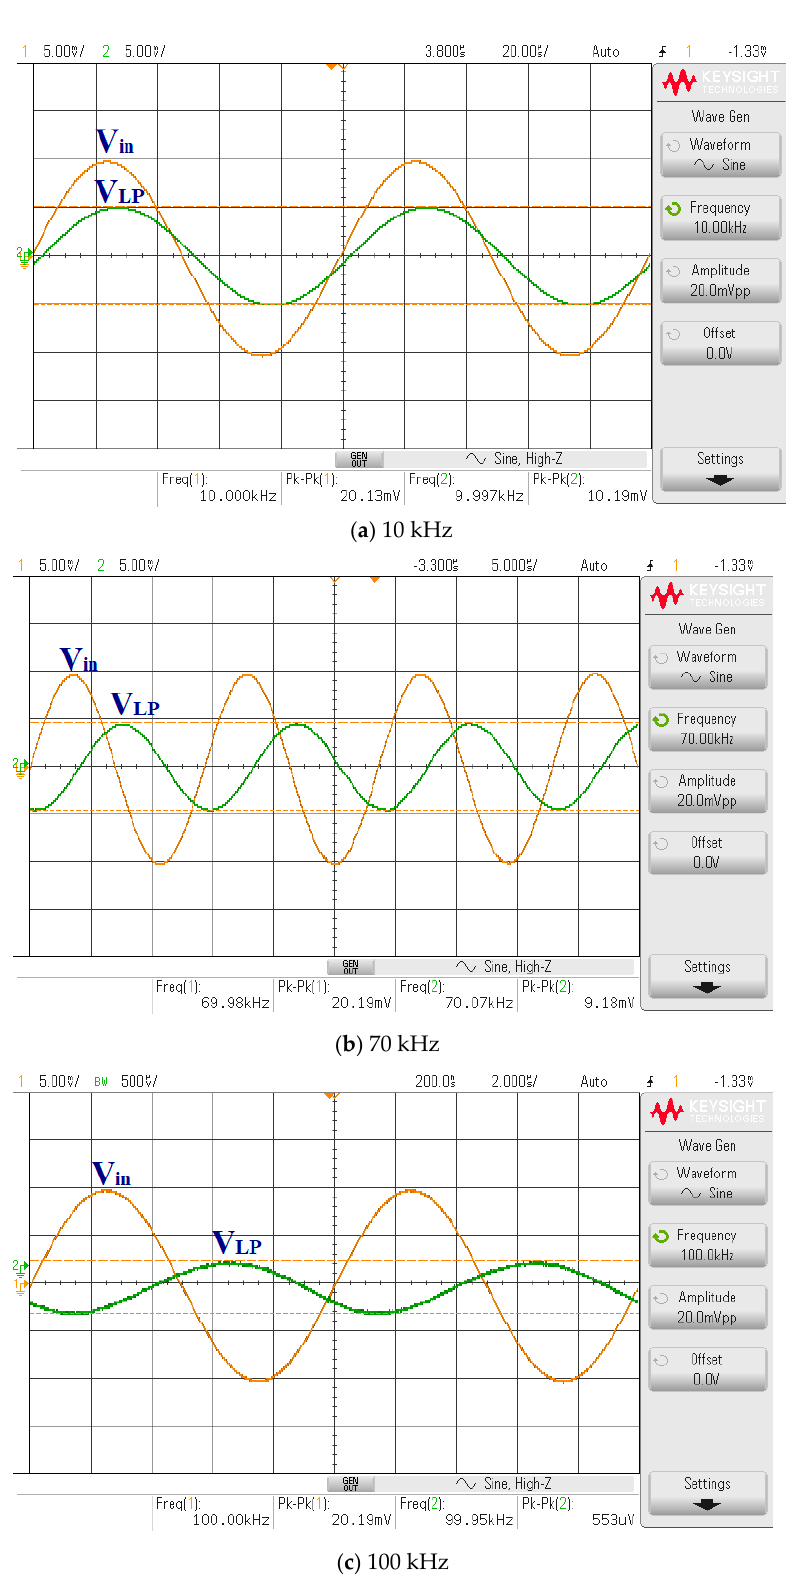
Figure 40. The experimental frequency responses of the LP ladder filter based on VD-DIBA com- pared with the theoretical response of the RLC prototype filter.